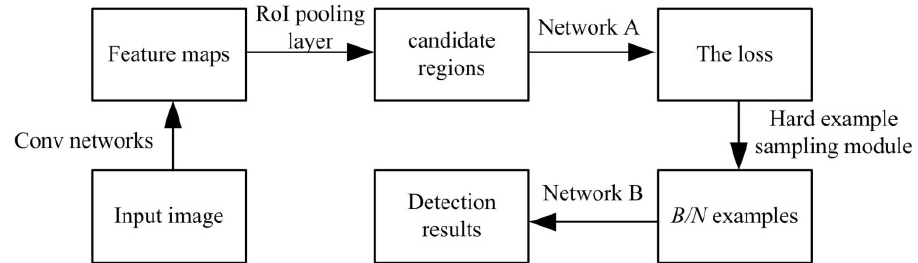
Figure 7. The flowchart of hard example mining.